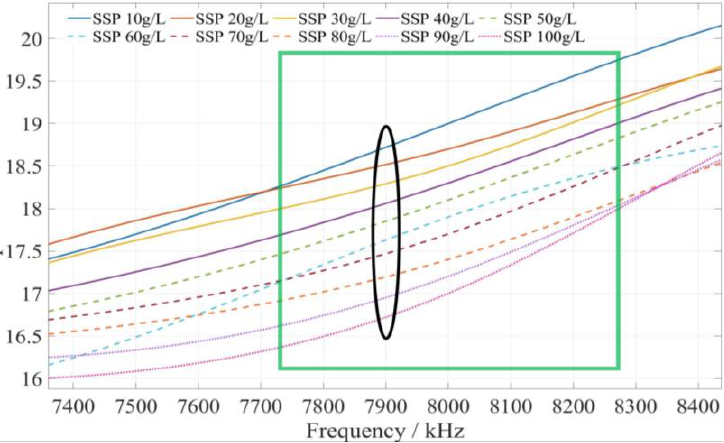
Figure 11. The amplitude – frequency characteristic curve of the SSP fertilizer solution under the excitation signal of 7740~8280 kHz.